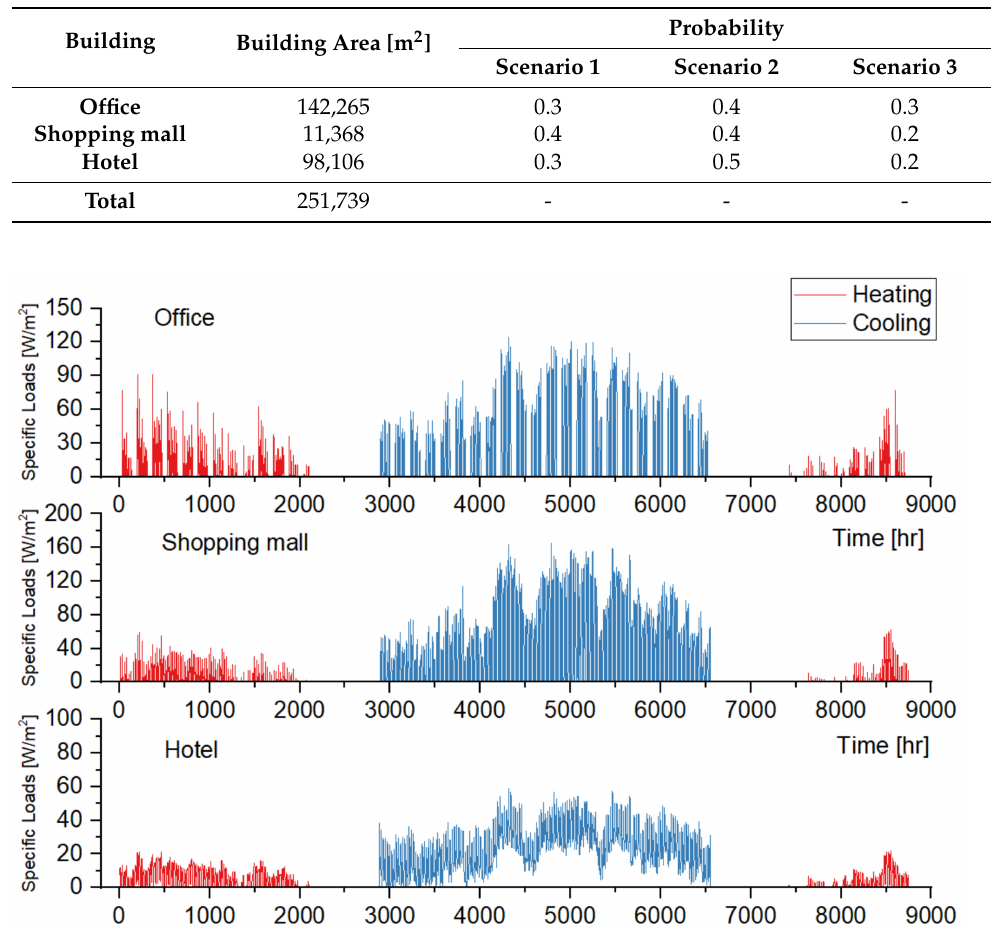
Table 8. Building areas and scenario settings of 3 types of buildings.